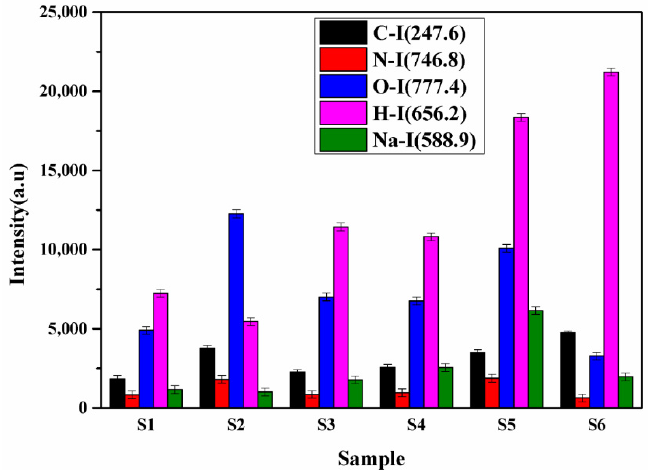
Figure 7. The integrated intensities of the spectral line of C, N, O, H, and Na.